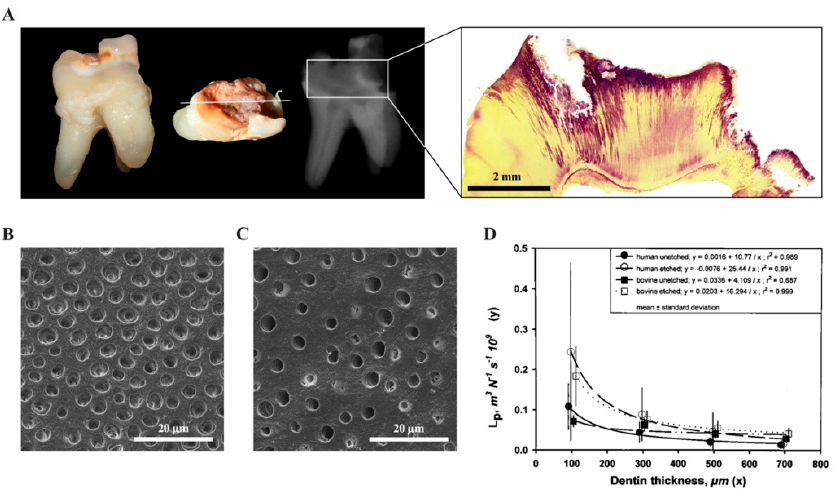
Figure 3. The carious process (own collection). ( A ) Extracted tooth with a deep carious lesion: clinical, radiographic and histologic appearance. The carious process has degraded enamel and dentine, which can be seen as radiolucent areas on the radiograph. After Brown and Brenn staining of the same tooth, bacteria are visible in the dentinal tubules (purple). ( B ) Dentine surface with dentinal tubules in a deep lesion close to the pulp and ( C ) a shallow cavity. ( D ) Permeability of dentine represented by hydraulic conductance L p as a function of thickness for human and bovine dentin. Points with vertical lines represent the means and SD of the original data; lines represent the regressions of y vs. 1/x. (modified from